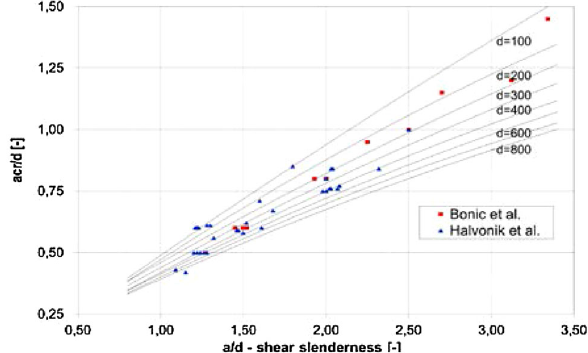
Fig. 12 Relation between a cr / d and shear slenderness a / d and comparison with experimental